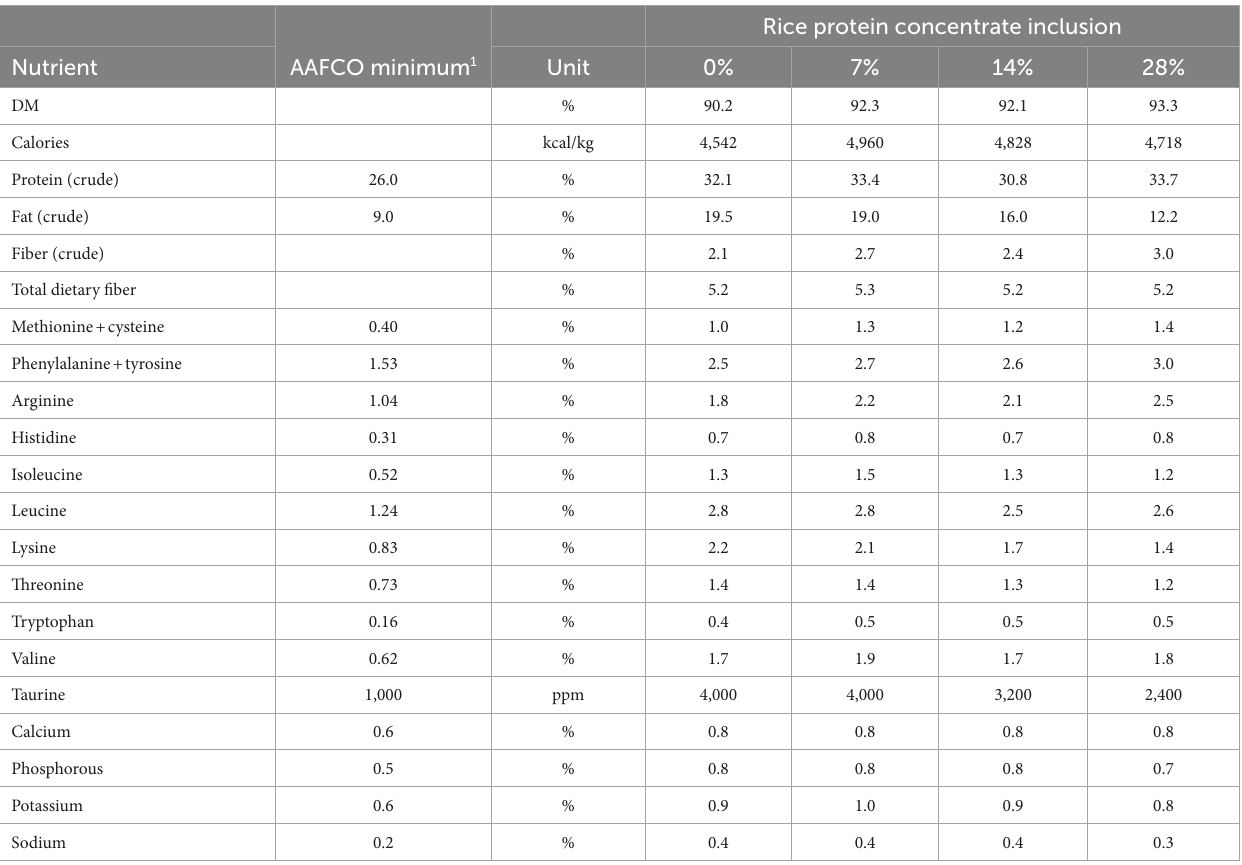
TABLE 3 Analyzed nutrient composition and energy content of test foods containing increasing levels of rice protein concentrate (RPC) on a dry matter